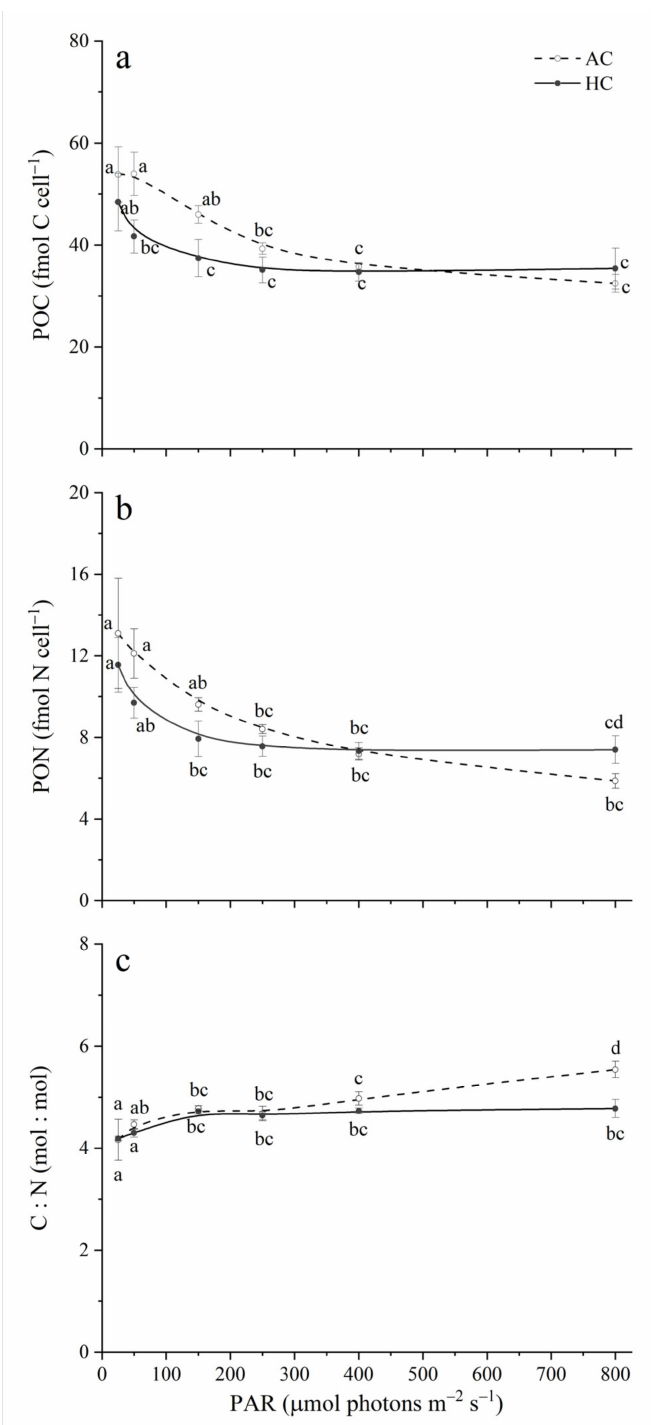
Figure 6. Particulate organic carbon (POC) ( a ) and nitrogen (PON) ( b ) and the C:N ratio (mol:mol) ( c ) of Synechococcus cells grown under different light levels combined with the ambient (AC, 415 µ atm, the dotted line) or elevated (HC, 1000 µ atm, the solid line) p CO 2 . The values are means ± SD of triplicate cultures. Different letters indicate significant ( p < 0.05) differences among the